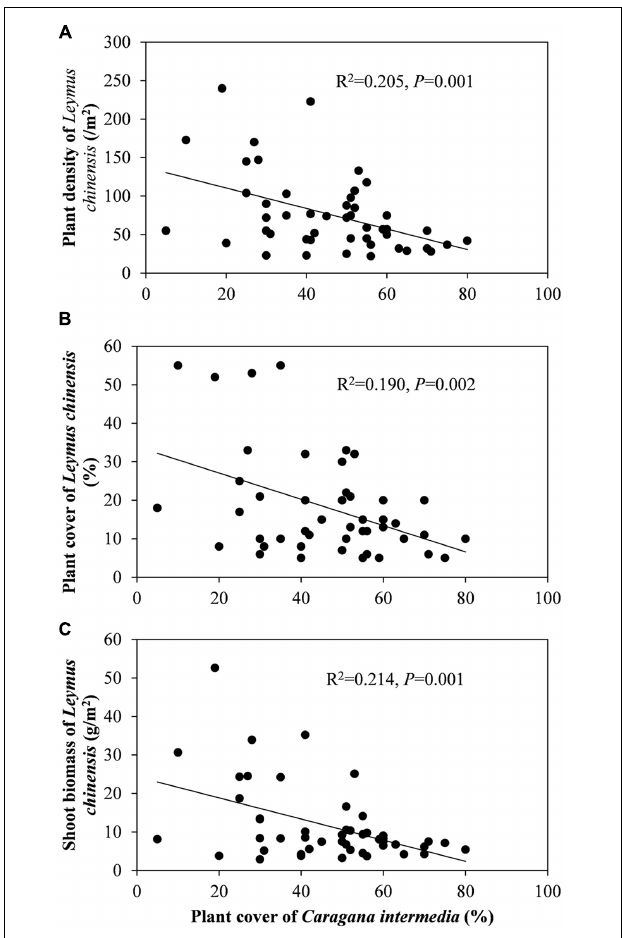
FIGURE 3 | Relationship between plant cover of Caragana intermedia and plant density (A) , plant cover (B) and plant shoot biomass (C) of Leymus chinensis beneath the canopies of C. intermedia